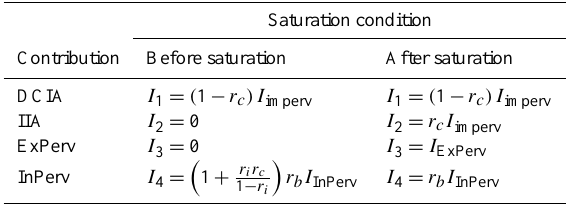
Table 1. Precipitation for each contribution in urban catchments.